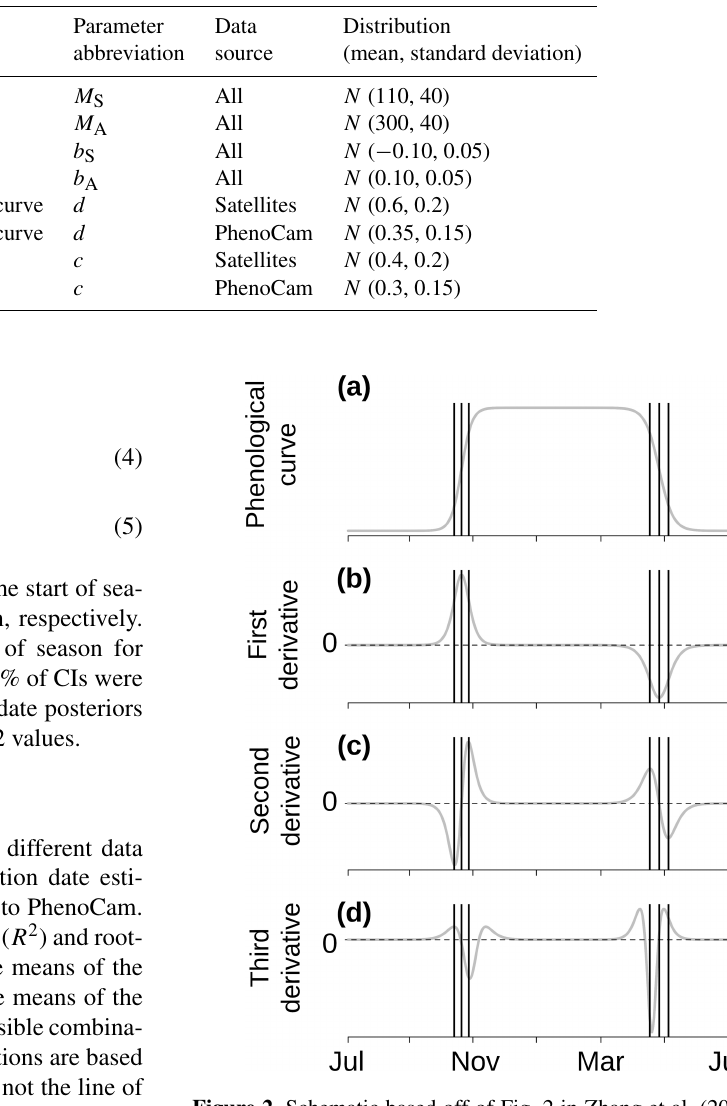
Figure 2. Schematic based off of Fig. 2 in Zhang et al. (2003) de- scribing the selection of transition dates (shown using the vertical lines). Panel (a) illustrates an example phenological curve of green- down and green-up. Panel (b) illustrates the first derivative. Panel (c) illustrates the second derivative where the root (second deriva- tive equals 0) gives the value of the date of the middle of season. Panel (d) illustrates the third derivative where the roots give the start and end of both